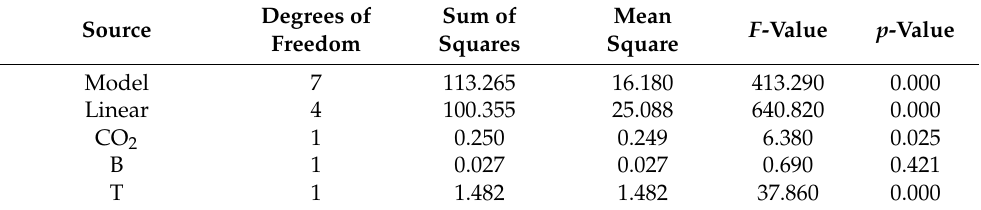
Table 8. ANOVA results of compressive strength (after backward